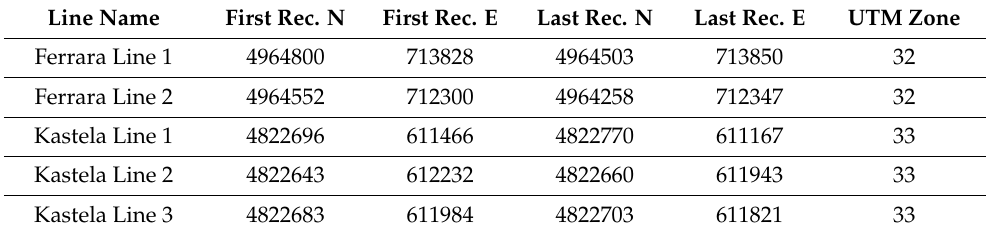
Table 1. UTM coordinates of the first and last receiver of each acquired seismic